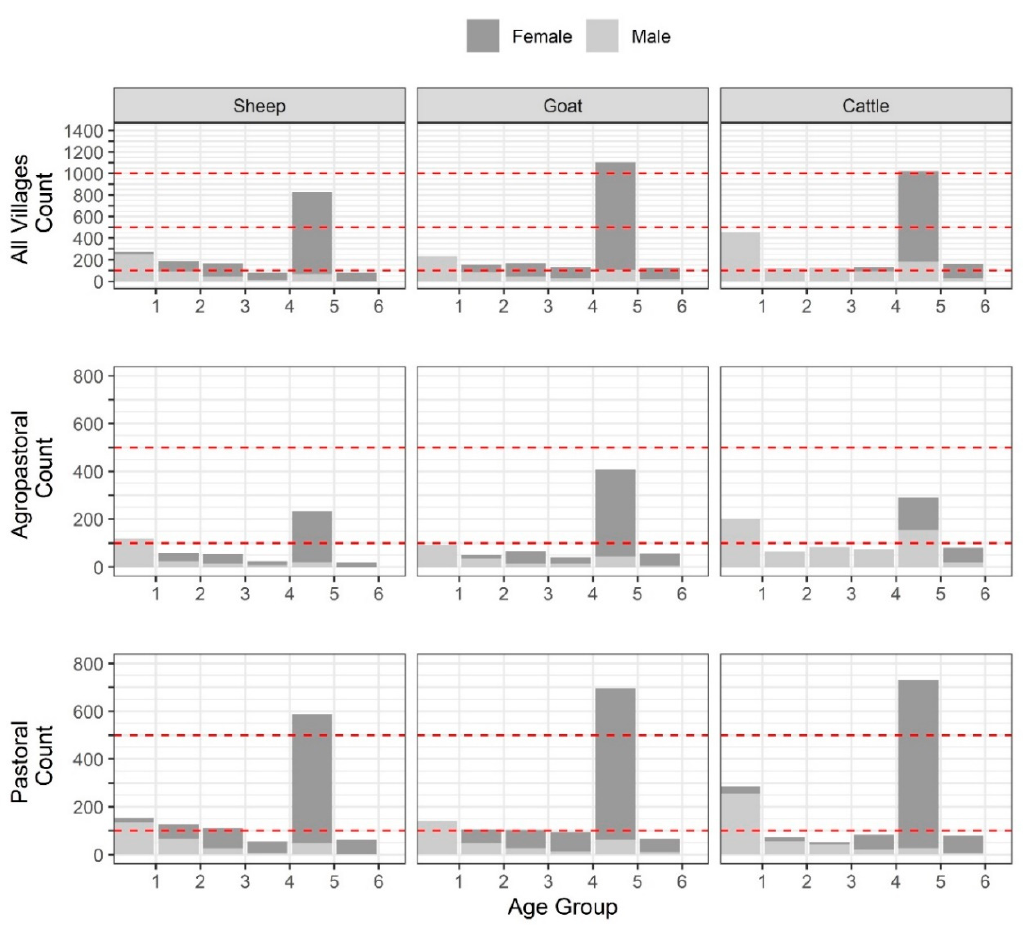
Figure 2. Dentition-based age group distribution by species, sex, and management system.